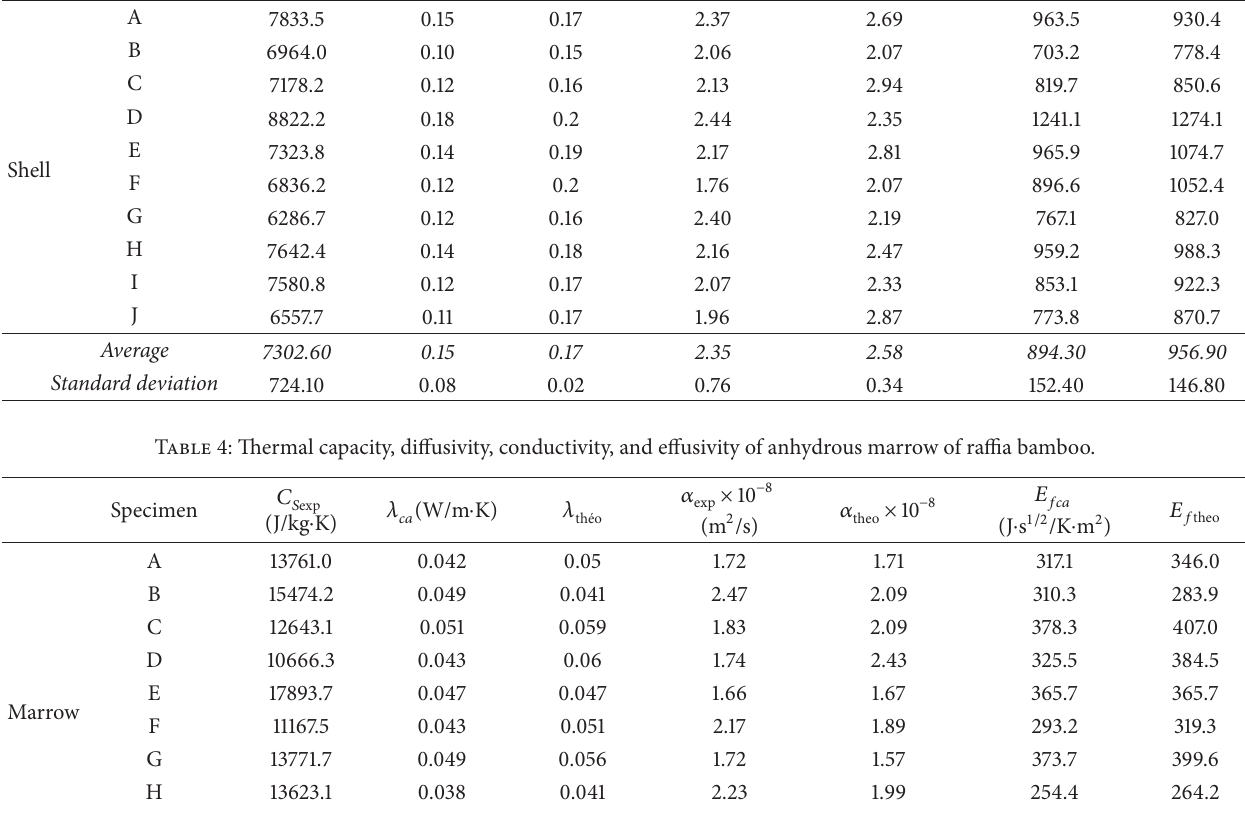
Table 3: Thermal capacity, diffusivity, conductivity, and effusivity of the shell of raffia bamboo. Specimen